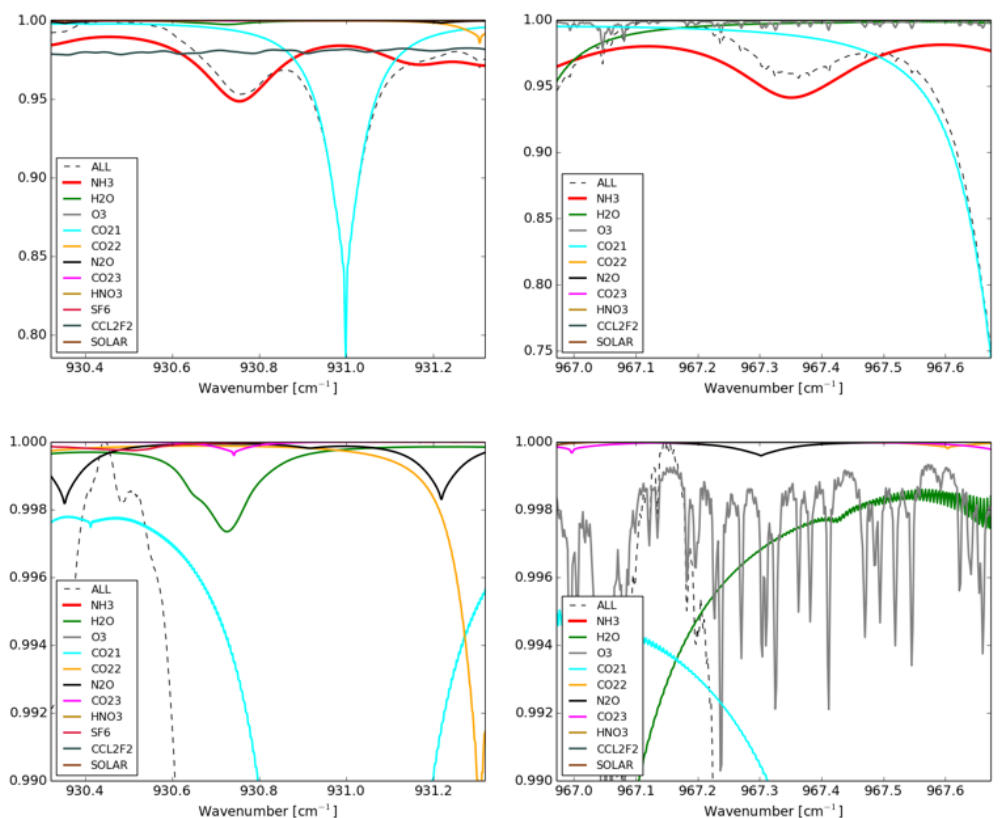
Figure 1. Calculated spectrum for both spectral windows measured with the 125HR in Bremen on the 19 April 2010 at 09:59UTC, corre- sponding to a total column of 18 . 83 × 10 15 molecules cm − 2 . The top two panels show the individual contributions of the different species in the first (MW1) and second (MW2) spectral windows. The second row shows the same calculated spectra but now with the y-axis scaled to show the minor interfering